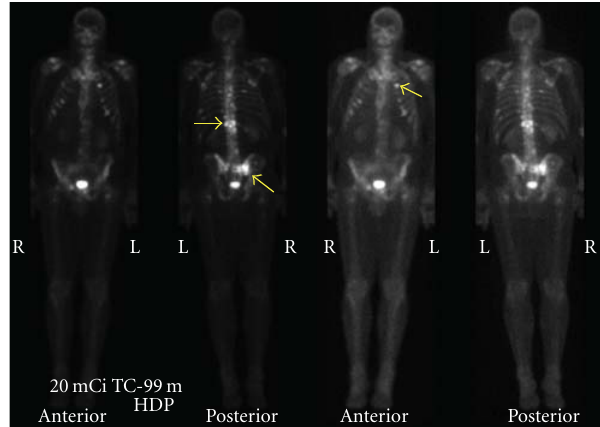
Figure 2: Anterior and posterior bone scan planar images reveal multiple foci of increased radionuclide uptake, not only in the thor- acic and lumbar spine but also in the ribs and sacrum (yellow